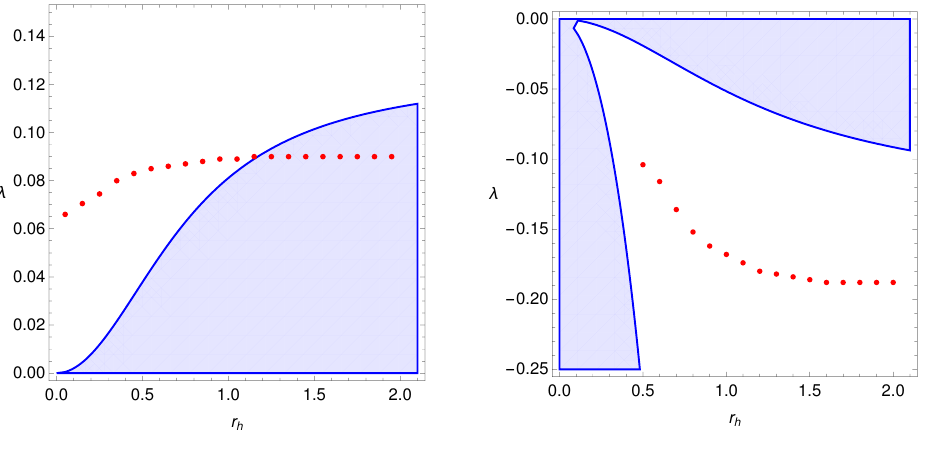
Figure 3. Results from [34]. Constraints on the parameter space ( r h ; (cid:21) ) of the spherical AdS Gauss-Bonnet black hole soluton due to: hyperbolicity (Blue), and boundary causality (Red). The region outside the shaded region or above (below in the right (cid:12)gure) the dots is not allowed. For the reference, in (cid:12)gure 3 we repeat the result of [34] summarizing the constraints from boundary causality and hyperbolicity.